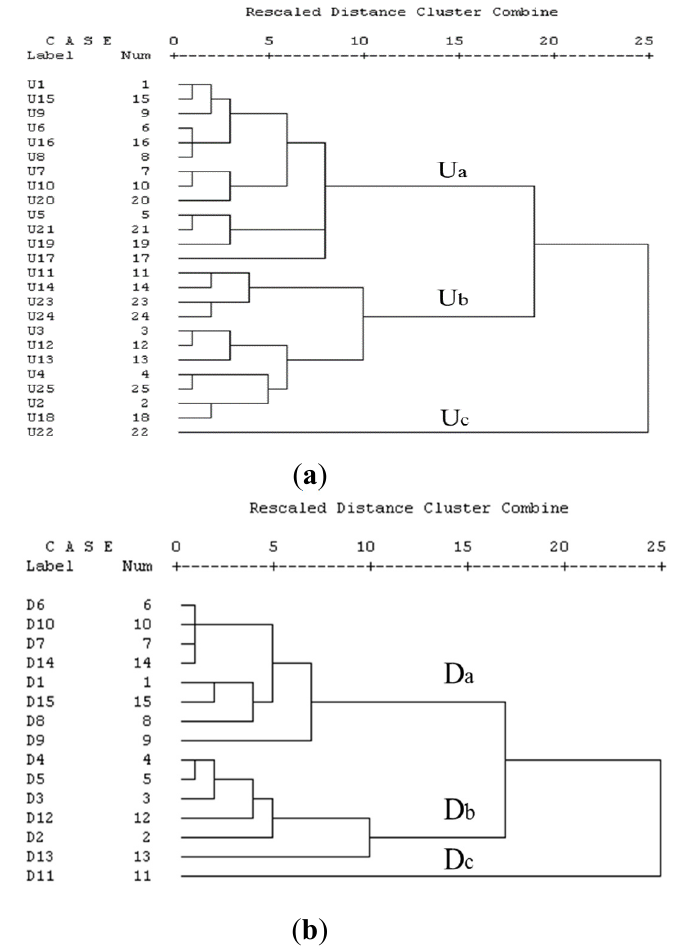
Figure 3. Dendrogram of the cluster analysis of metal concentrations in the study area. ( a ) Upstream (U); ( b ) downstream